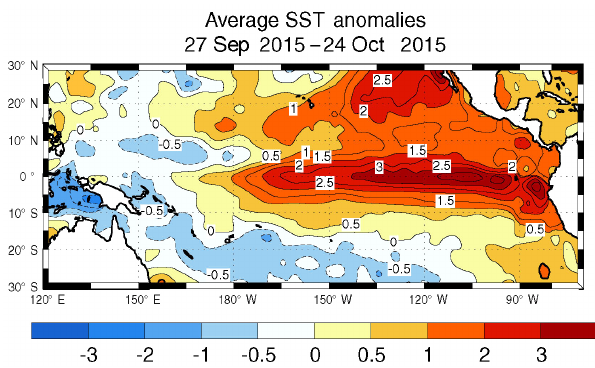
Figure 2. Average sea surface temperature anomalies in ◦ C for the period 27 September to 24 October 2015. Image with permission from NOAA extracted from the http://www.cpc.ncep.noaa.gov/products/analysis_monitoring/ lanina/enso_evolution-status-fcsts-web.pdf file version from 26 October 2015, redrawn with very minor modifications to improve the figure